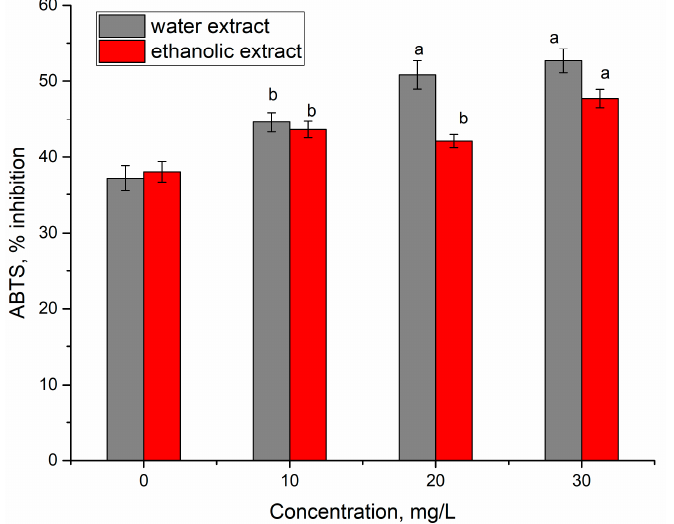
Figure 8. The antioxidant activity of extracts from A. platensis biomass exposed to Y(III) at concentrations 10–30 mg/L (a— p < 0.0005, b— p < 0.005 for the difference between sample and control).